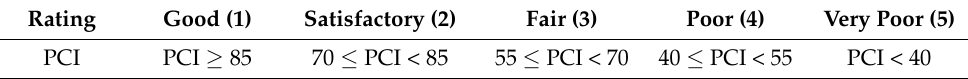
Table 1. Evaluation criteria for the apparent condition of the airport’s rigid pavement surface.